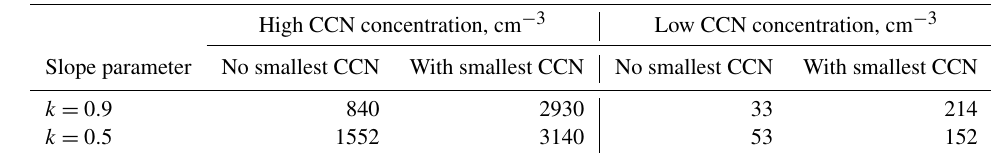
Table 2. CCN concentrations in different experiments in the boundary layer.